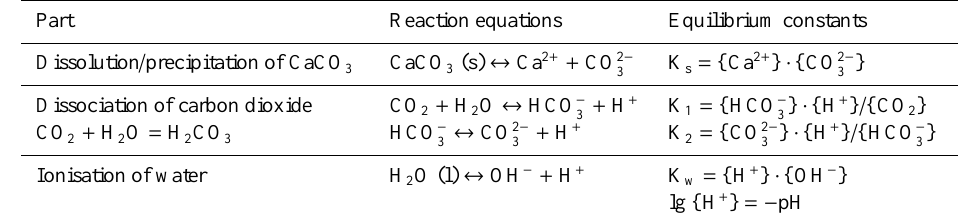
{X} = relative activity of dissolved species / ion X.